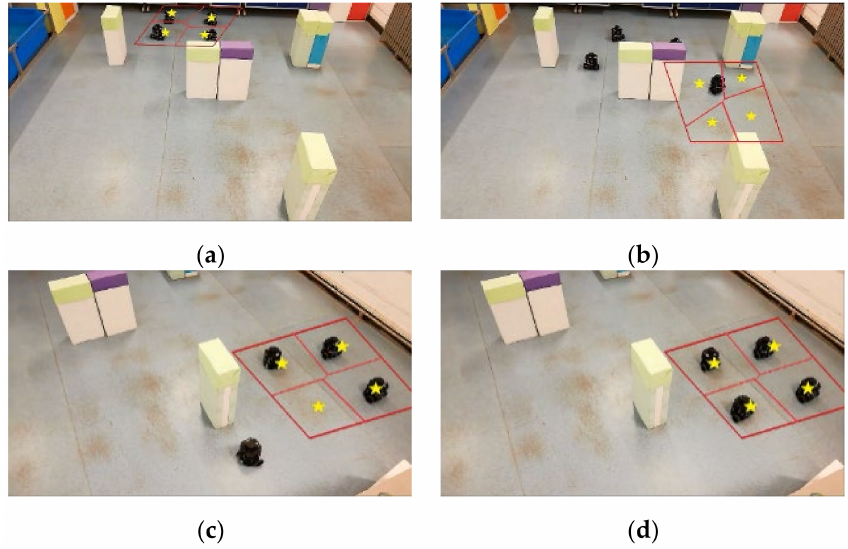
Figure 22. Multi-robot dynamic formation experiment with random obstacles: ( a ) t 1 = 0 s; ( b ) t 2 = 32 s; ( c ) t 3 = 80 s; ( d ) t 4 = 102 s.